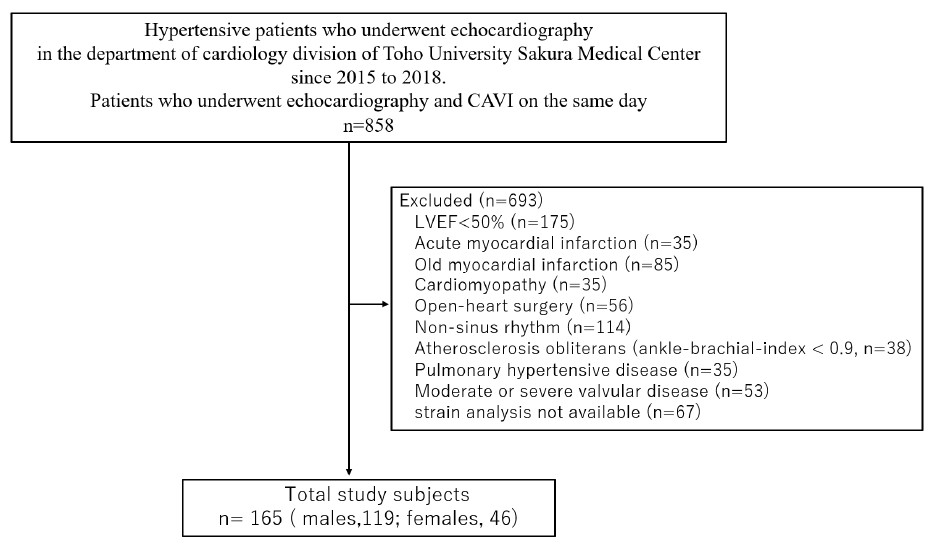
Figure 4. Flow chart showing patient selection. CAVI, cardio-ankle vascular index; LVEF, left ven- tricular ejection fraction.